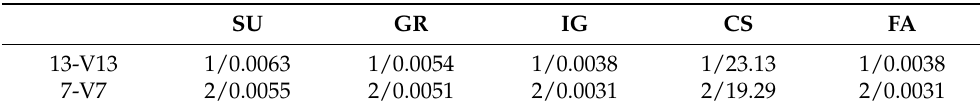
Table 5. Feature selection using five filter ranker classifiers (smaller serial number represents bigger rank of